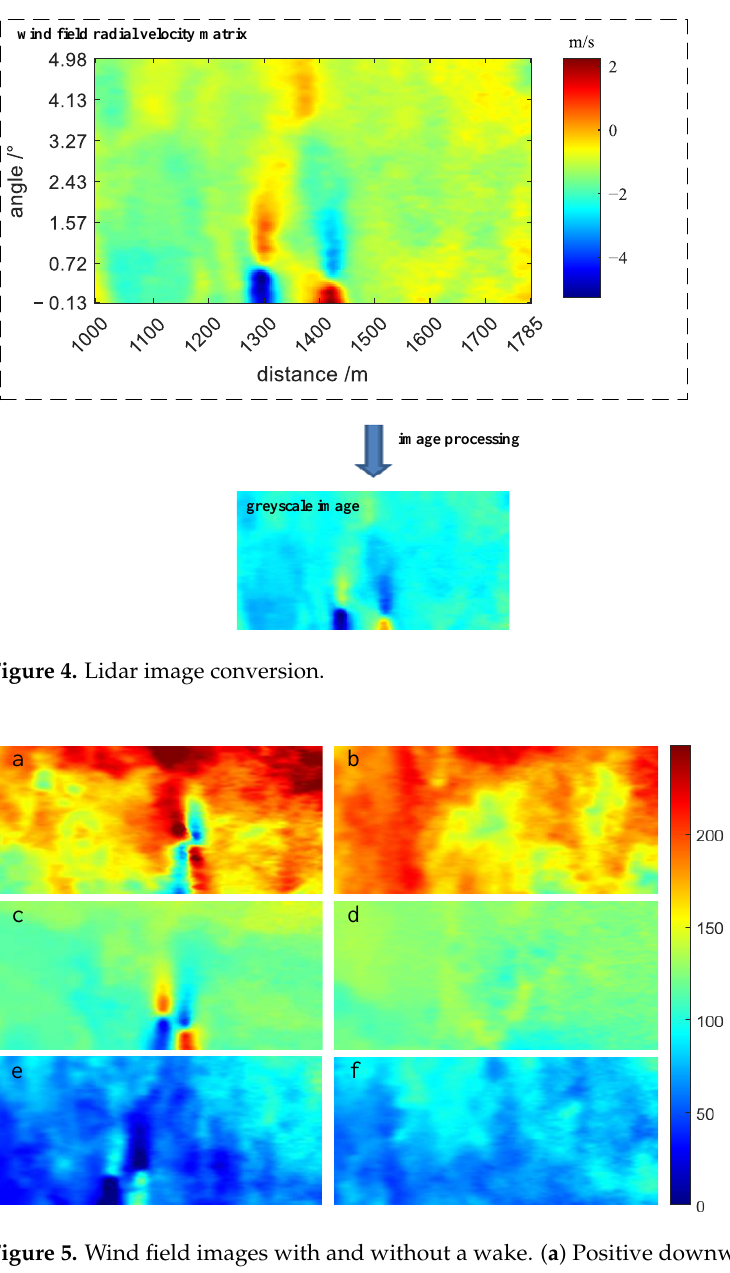
Figure 5. Wind field images with and without a wake. ( a ) Positive downwind; ( b ) negative down- wind; ( c ) positive calm wind; ( d ) negative calm wind; ( e ) positive headwind; ( f ) negative headwind.